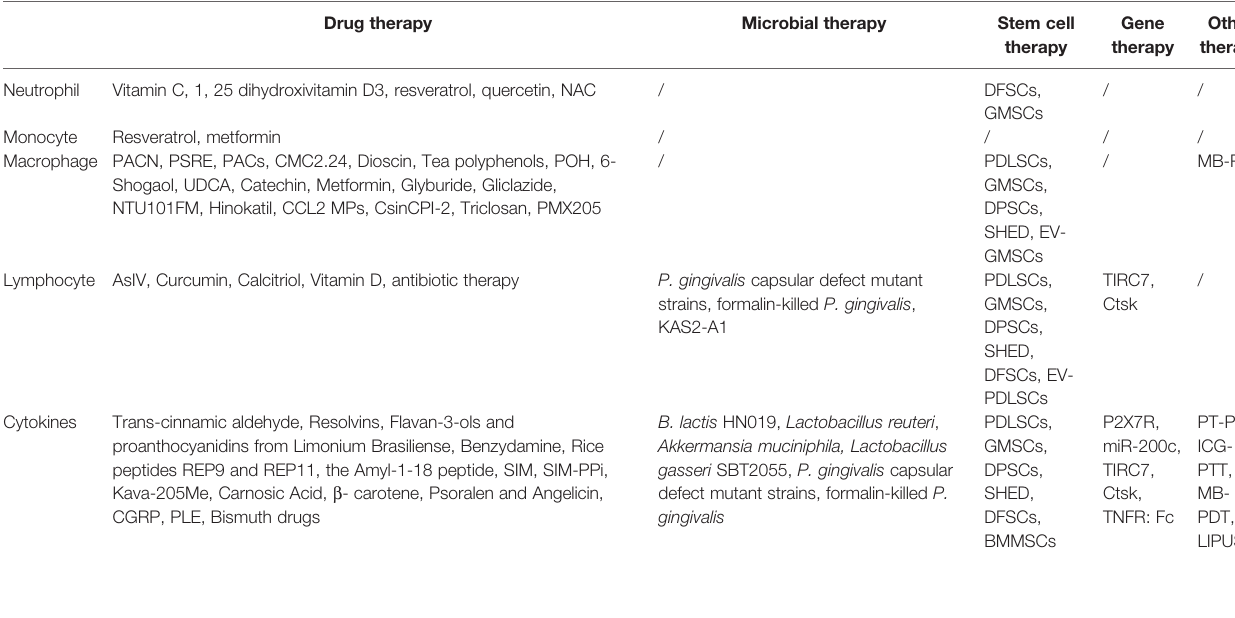
TABLE 4 | A summary of immunotherapies and their